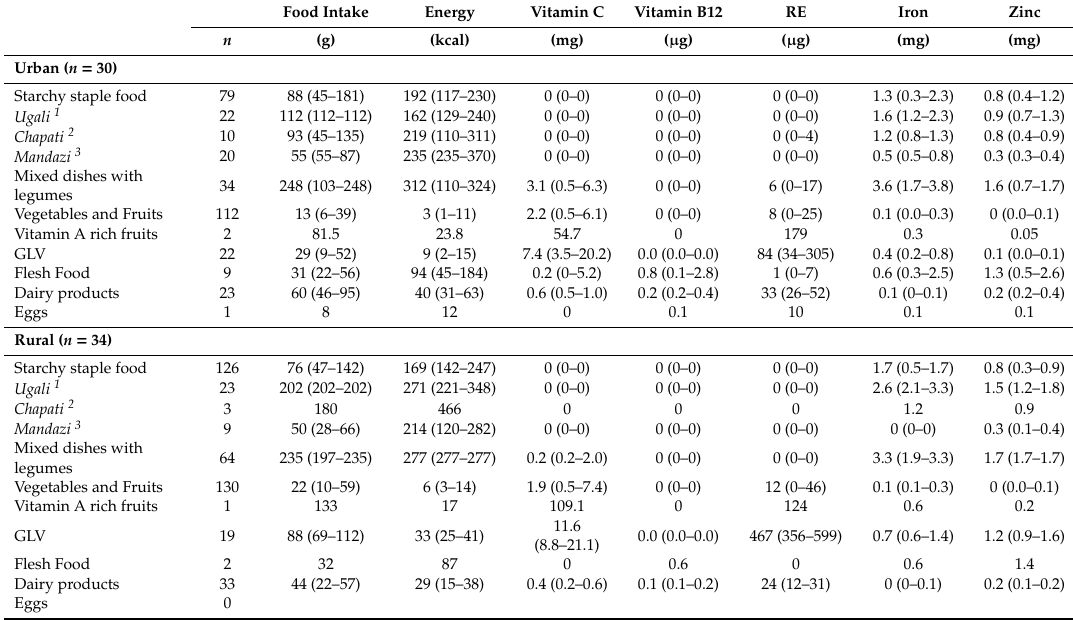
Table 6. Frequency (n), median (IQR) of intake in gram, energy, and nutrients from selected food groups of schoolchildren.